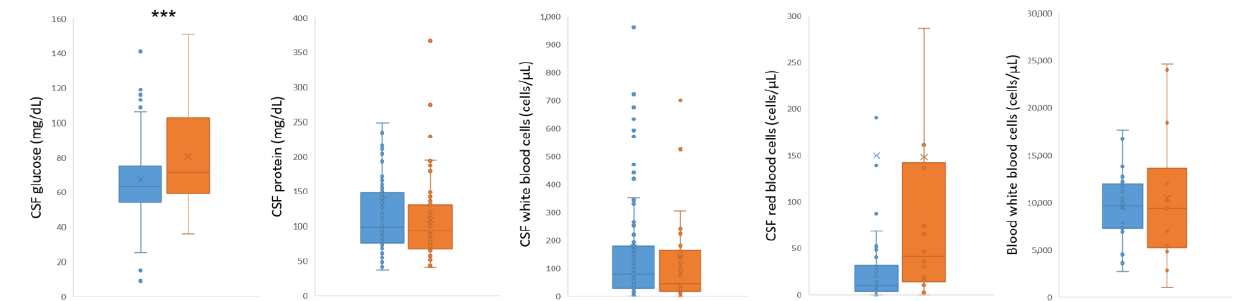
Figure 3. Average values of CSF and blood measurements between WNV-infected patients that recovered and those that deceased. Significant differences for measurement between the recovered and deceased groups of patients were assessed by a two-tailed t -test (two-sample assuming equal variances) and are indicated by (*** p < 0.001).